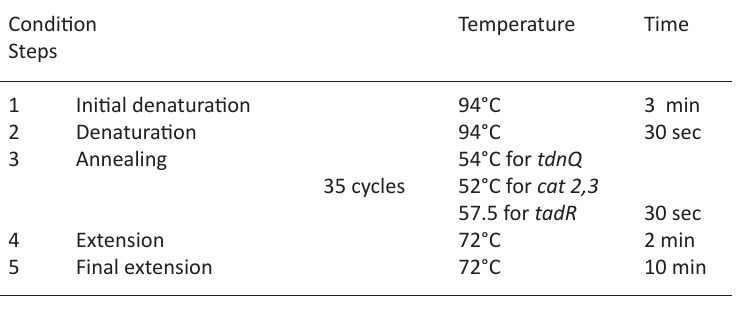
Table 3. The thermal profile used for the screening of aniline biodegradation genes by